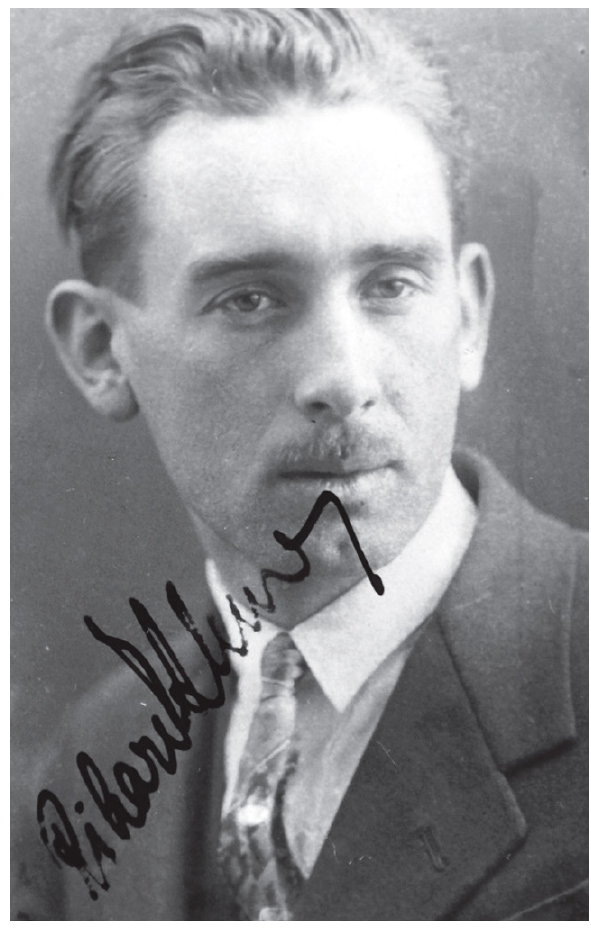
Figure 1: Identity photograph of Richard Klemen from 1930. Pho- tographed from his civil servant folder from University of Ljubljana Archives with